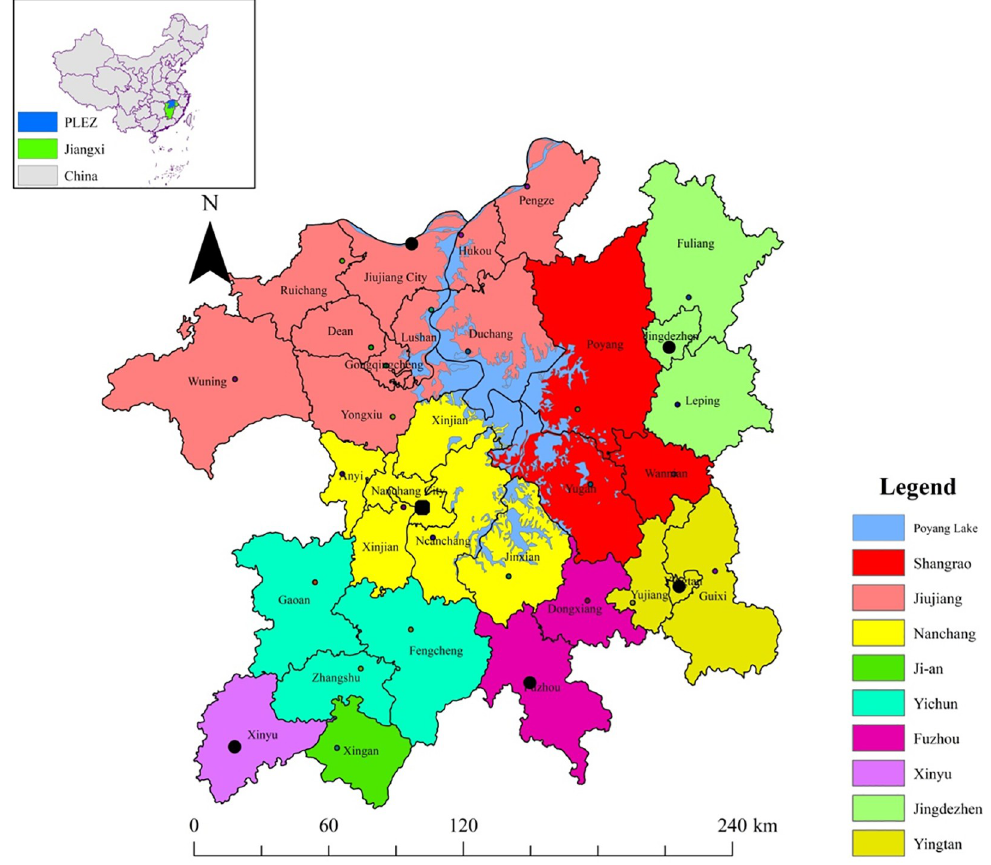
Fig 2. Location and administration division of the